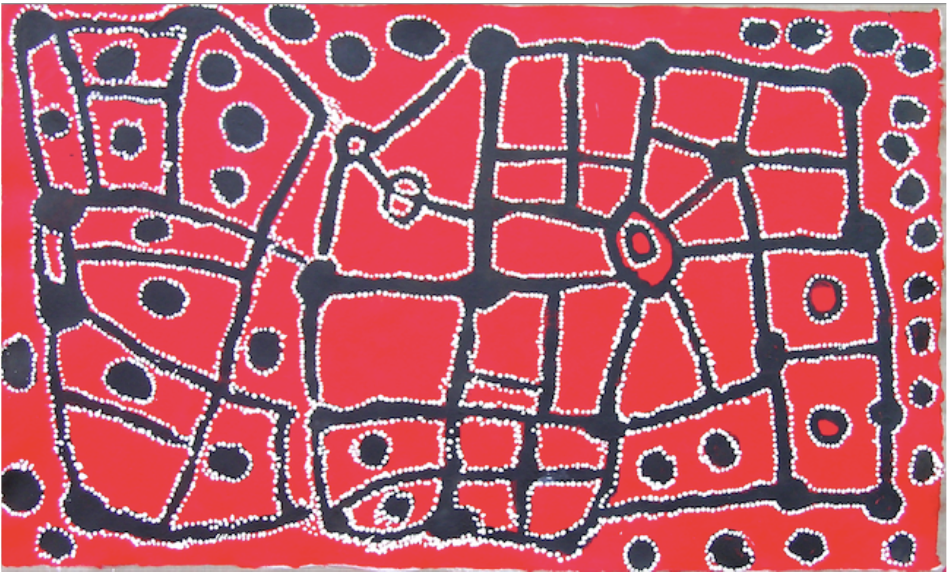
Kunmanara (Mark) Anderson and Kunmanara (Ester) Rice, Paltju , 2005. Acrylic on linen, 140 x 83 cm. Private collection (photo: courtesy Spinifex Arts